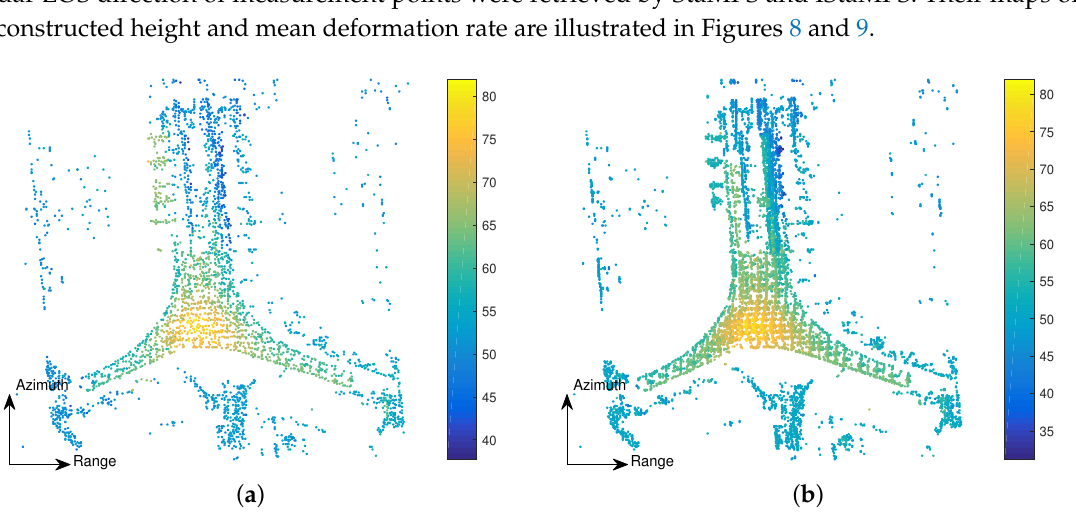
Figure 8. The reconstructed height maps of PS in T3 E area by: ( a ) StaMPS; and ( b ) IStaMPS